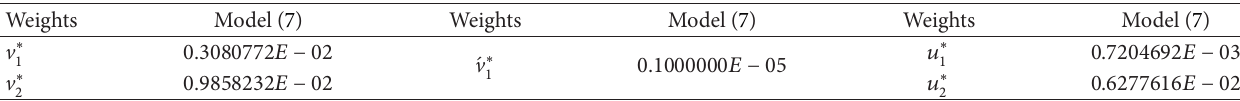
Table 5: The weights of model